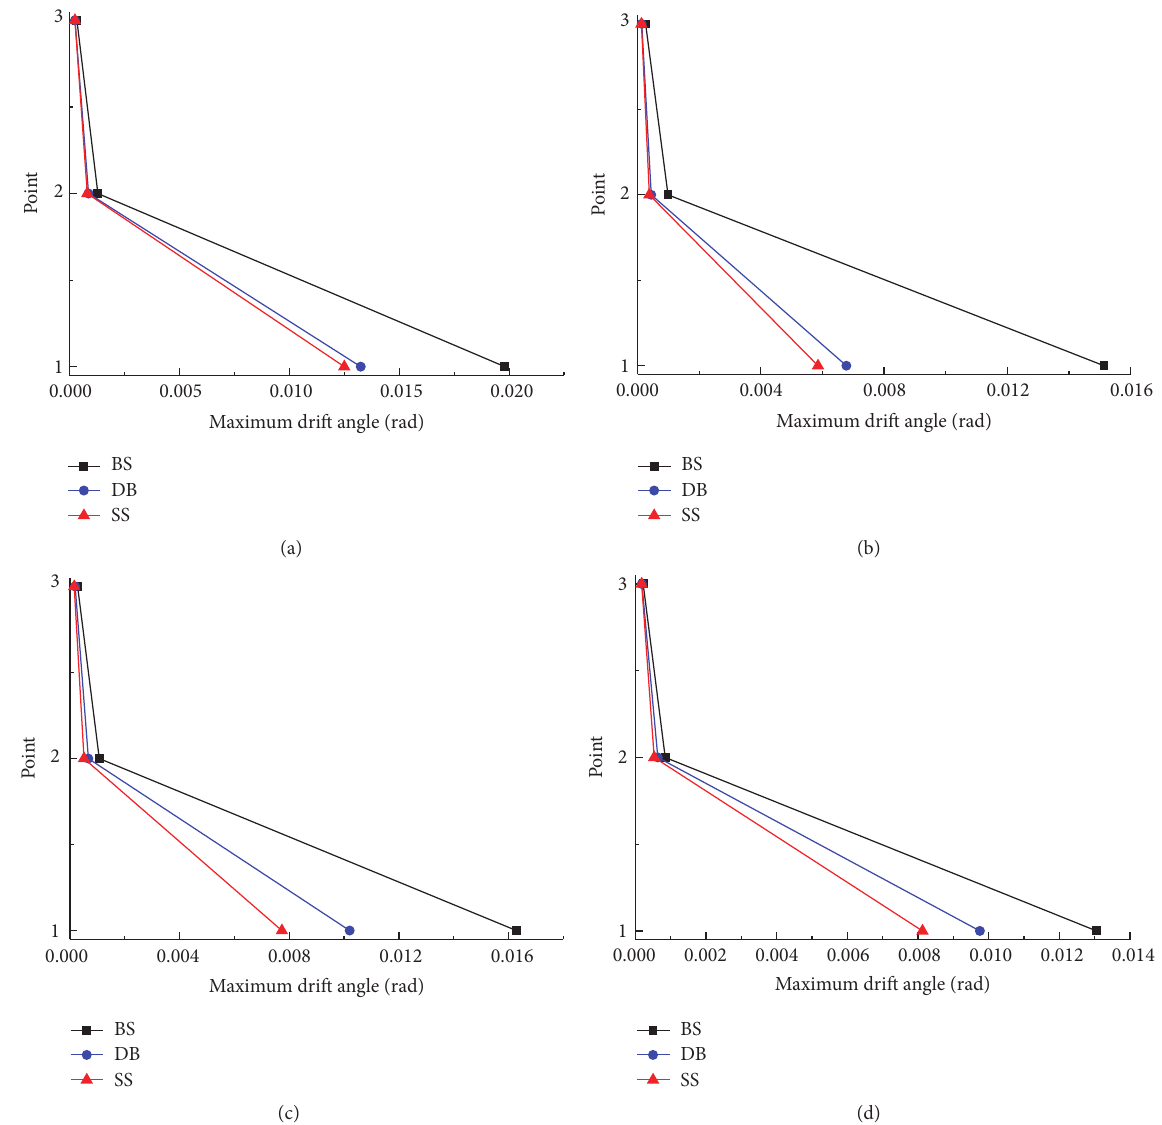
Figure 16: Maximum drift angle distribution for PGA = 0.4 g: (a) El Centro NS, (b) Taft EW, (c) Northridge EW, and (d) Kobe